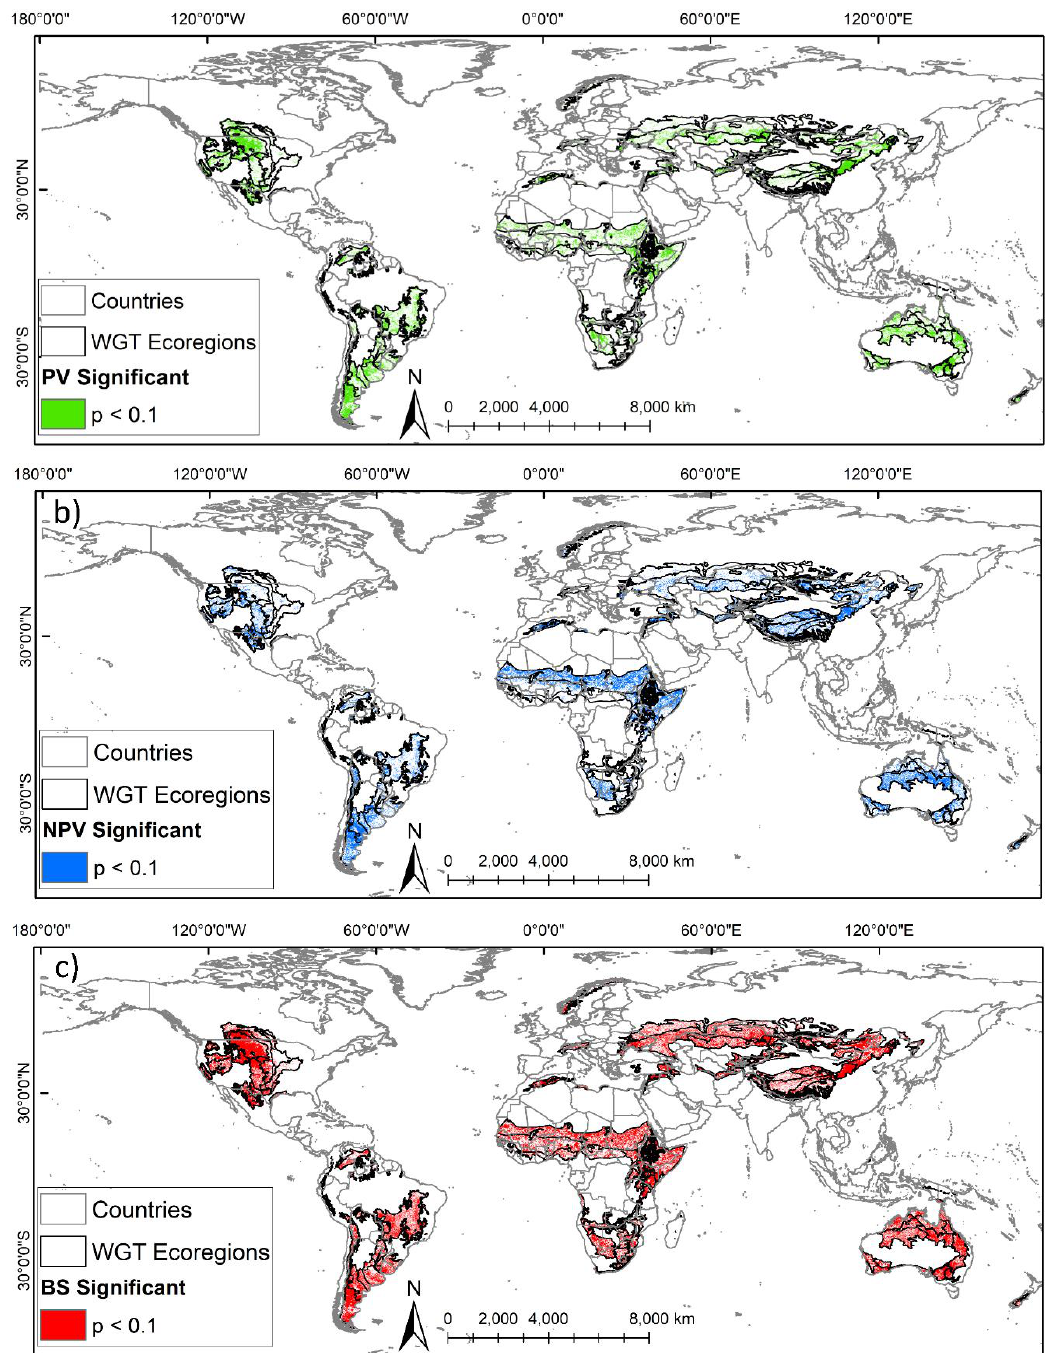
Figure 6. ( a ) The spatial distribution of pixels exhibiting significant long-term trends at p < 0.1 from 2001–2018 for F PV ; ( b ) The spatial distribution of pixels exhibiting significant long-term trends at p < 0.1 from 2001–2018 for F NPV ; and ( c ) The spatial distribution of pixels exhibiting significant long-term trends at p < 0.1 from 2001–2018 for F BS .